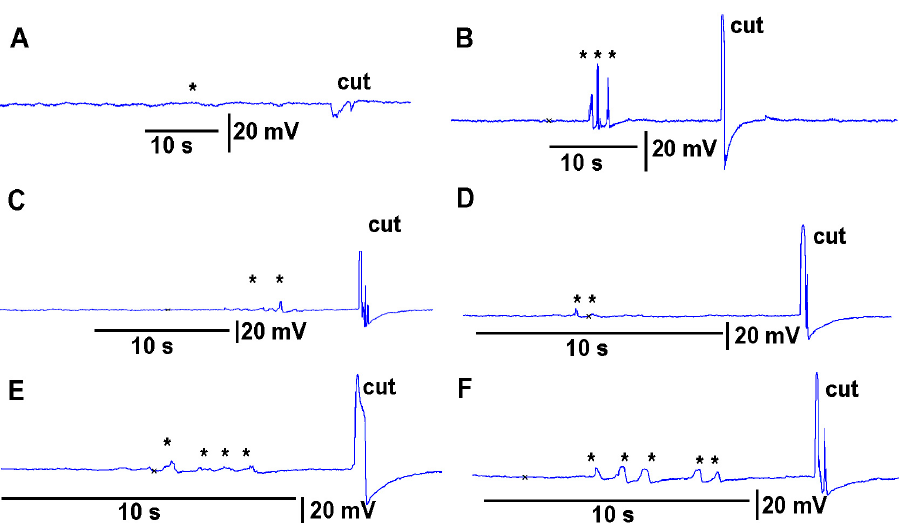
Figure 9. The effect of bending a leaf and cutting the same leaf while measuring the impedance changes by recording with both leads placed within the stem of pepper plants. ( A – F ) illustrates six different plants. The asterisk (*) shown in each recording demarcates a bending of the leaf as a test for the effect of movement on the leaf which occurs while cutting a